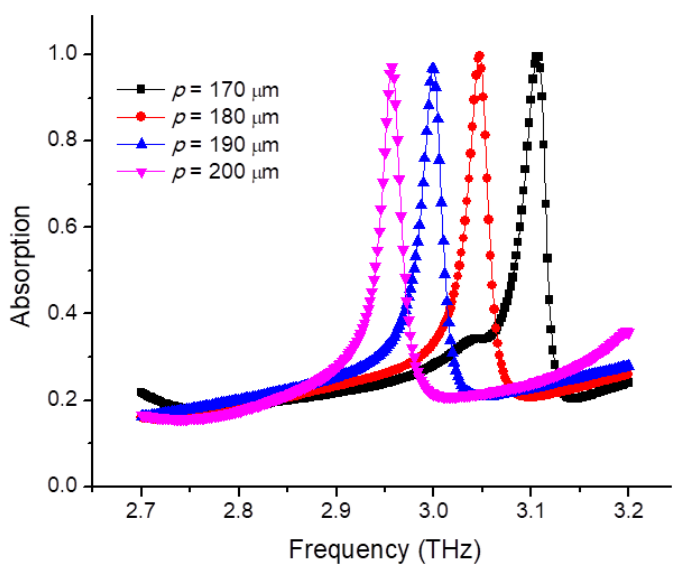
Figure 6. Absorption spectra obtained by varying the periodicity of the unit